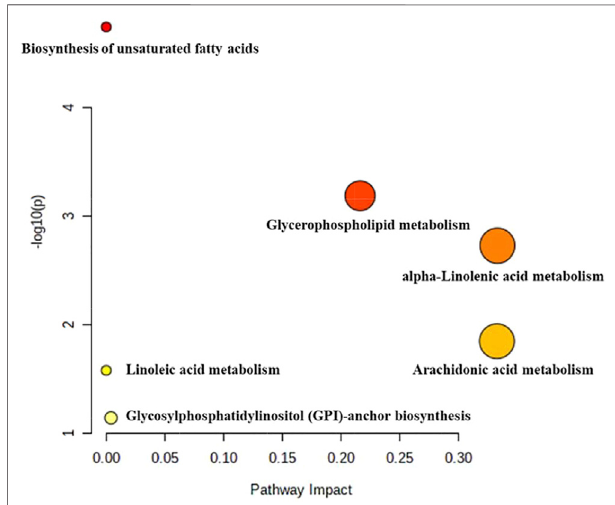
FIGURE 6| Analysis of metabolic pathways in abortion mice. The higher impact values were the glycerophospholipid metabolism, arachidonic acid metabolism, and alpha-linolenic acid metabolism